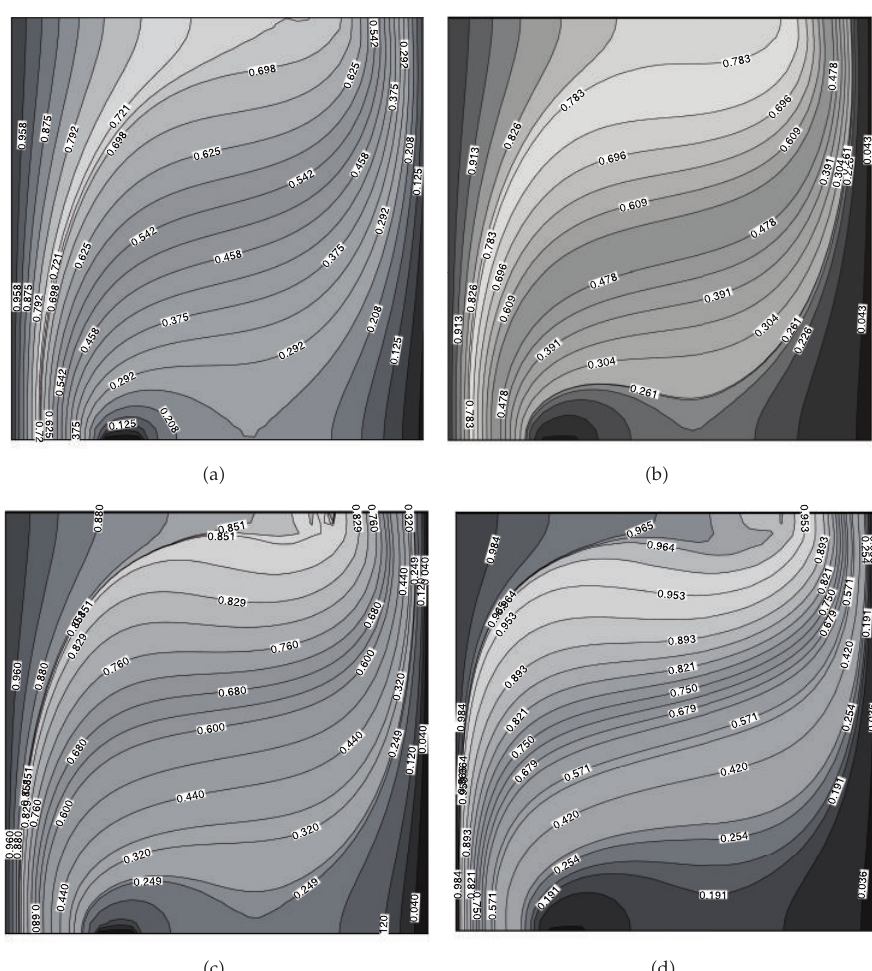
Figure 5: Isotherm contours along the left vertical wall while fixing Le (cid:8) 1, B (cid:8) 1, (cid:2) D/H (cid:3) (cid:8) 0 . 1, Ra (cid:8) 100, S C (cid:8) 0 . 1 for (cid:2) a (cid:3) a (cid:8) 0 . 0, (cid:2) b (cid:3) a (cid:8) 0 . 1, (cid:2) c (cid:3) a (cid:8) 0 . 25, (cid:2) d (cid:3) a (cid:8) 0 .